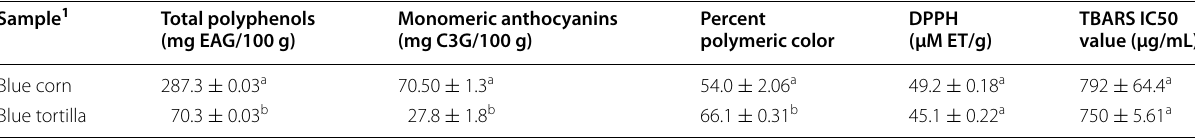
Table 1 Total polyphenol content, monomeric anthocyanins and antioxidant activity by DPPH and TBARS methods of blue corn and